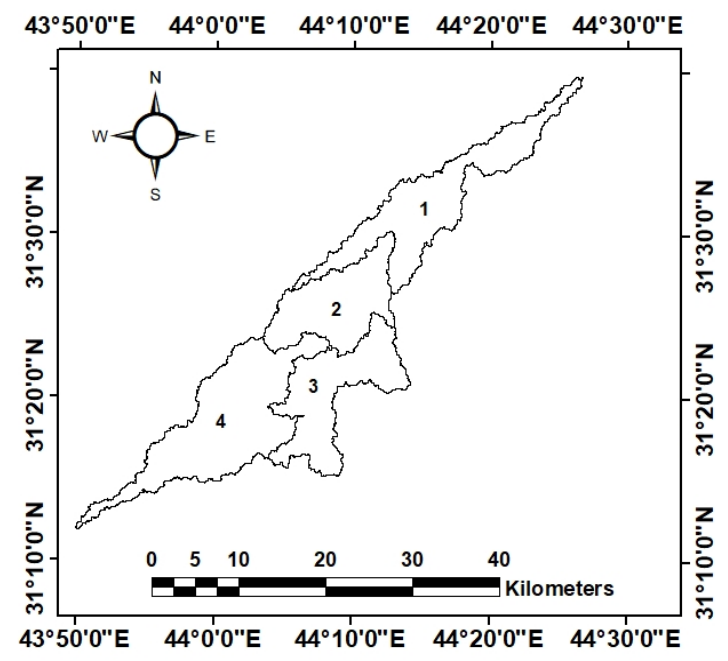
Fig. 9 The sub-basins of basin 3.